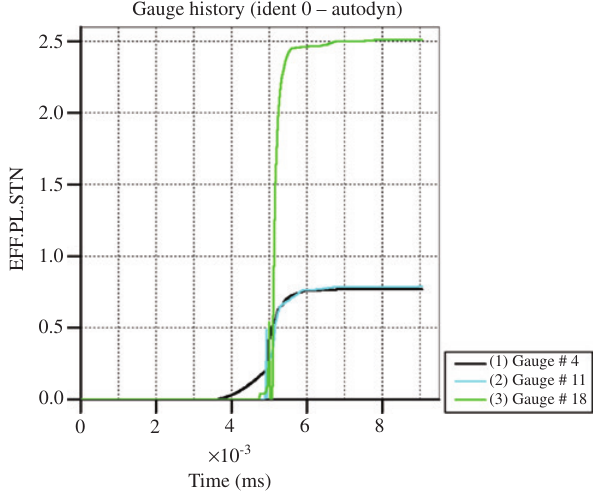
Figure 13: Effective plastic strain-time curve of the points 4, 11, and